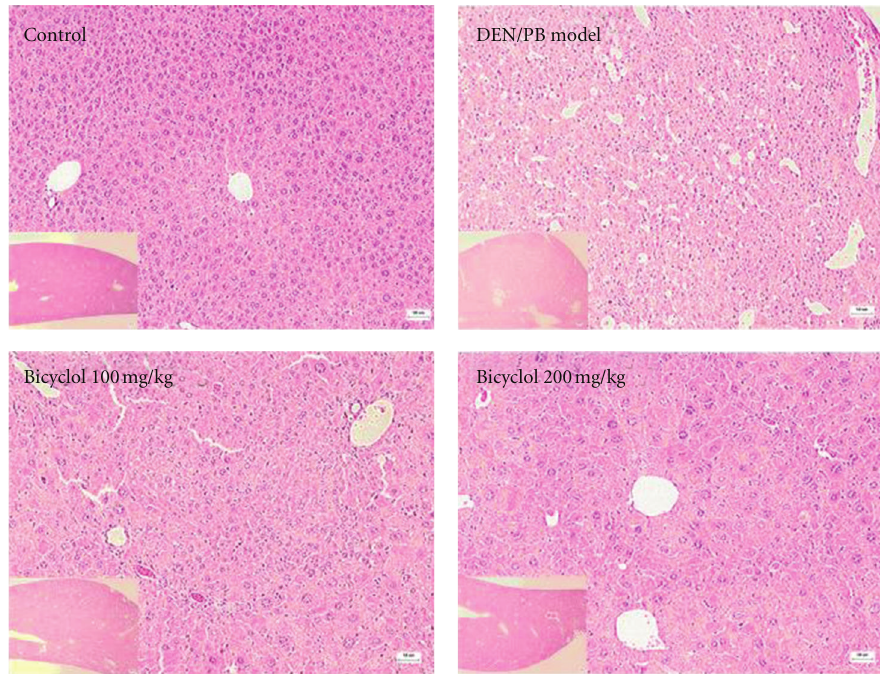
Figure 4: Histological study of the liver tissue obtained from the control and experimental groups at week 20. H&E-stained liver sections were photographed at 100x magnification. Insets in the bottom-left corners are images at 20x magnification of the liver tissue from which the 100x photographs were taken. Control group animals revealed normal architecture. DEN/PB-induced animals showed loss of architecture and presence of cancer cells. Animals pretreated with bicyclol (100, 200 mg/kg) showed fewer neoplastic cells and near-normal